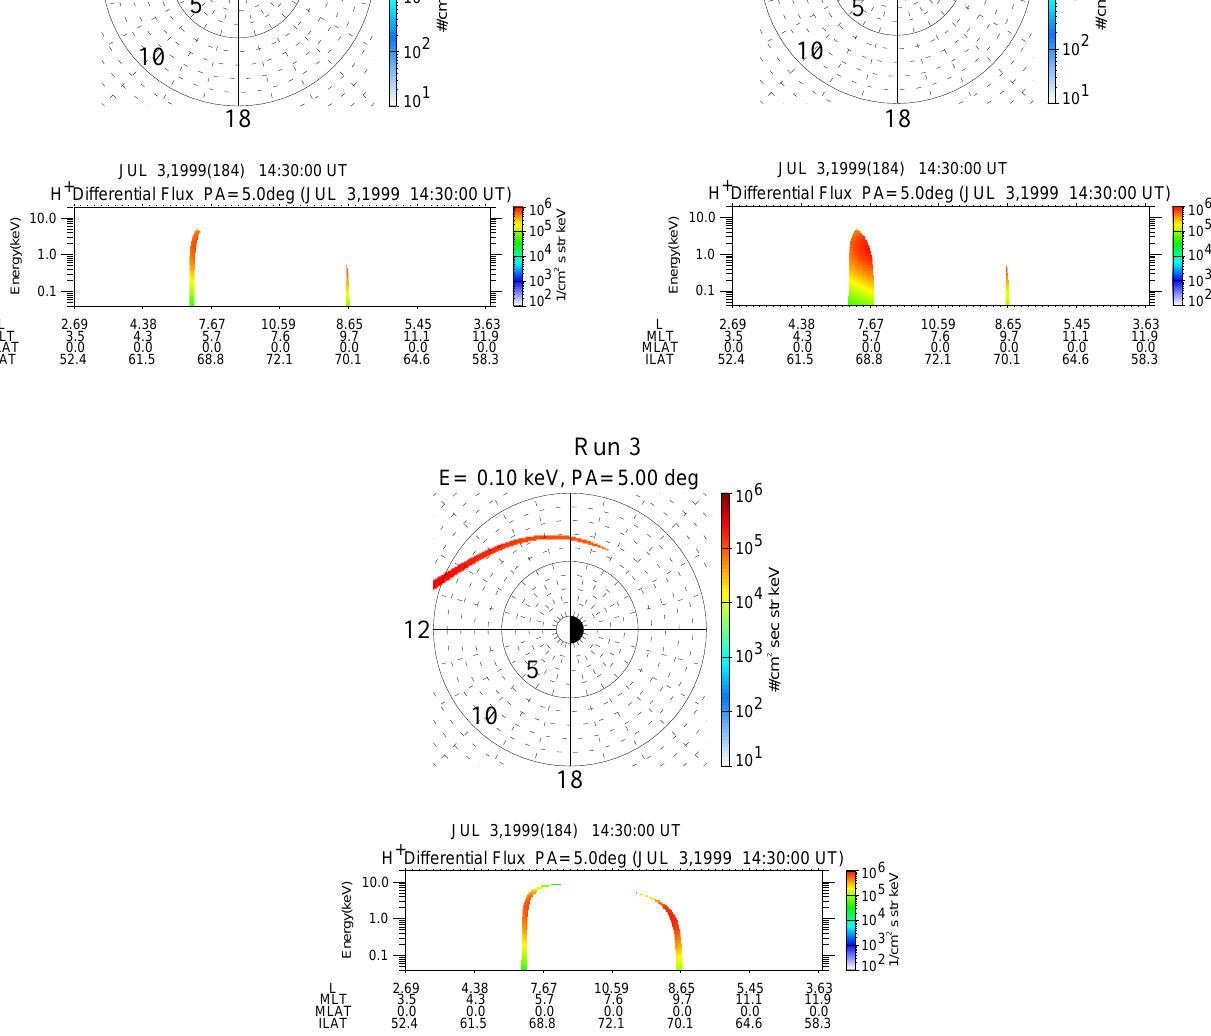
Fig. 7. Three simulations of the possible substorm injection on 3 July 1999. The three simulations are done with different boundary conditions (see description in the text). The upper panel gives the extension of the cloud at the time of observation by Astrid-2 (MLT and L -values are indicated), while the lower panel shows the resulting energy spectrum along the Astrid-2